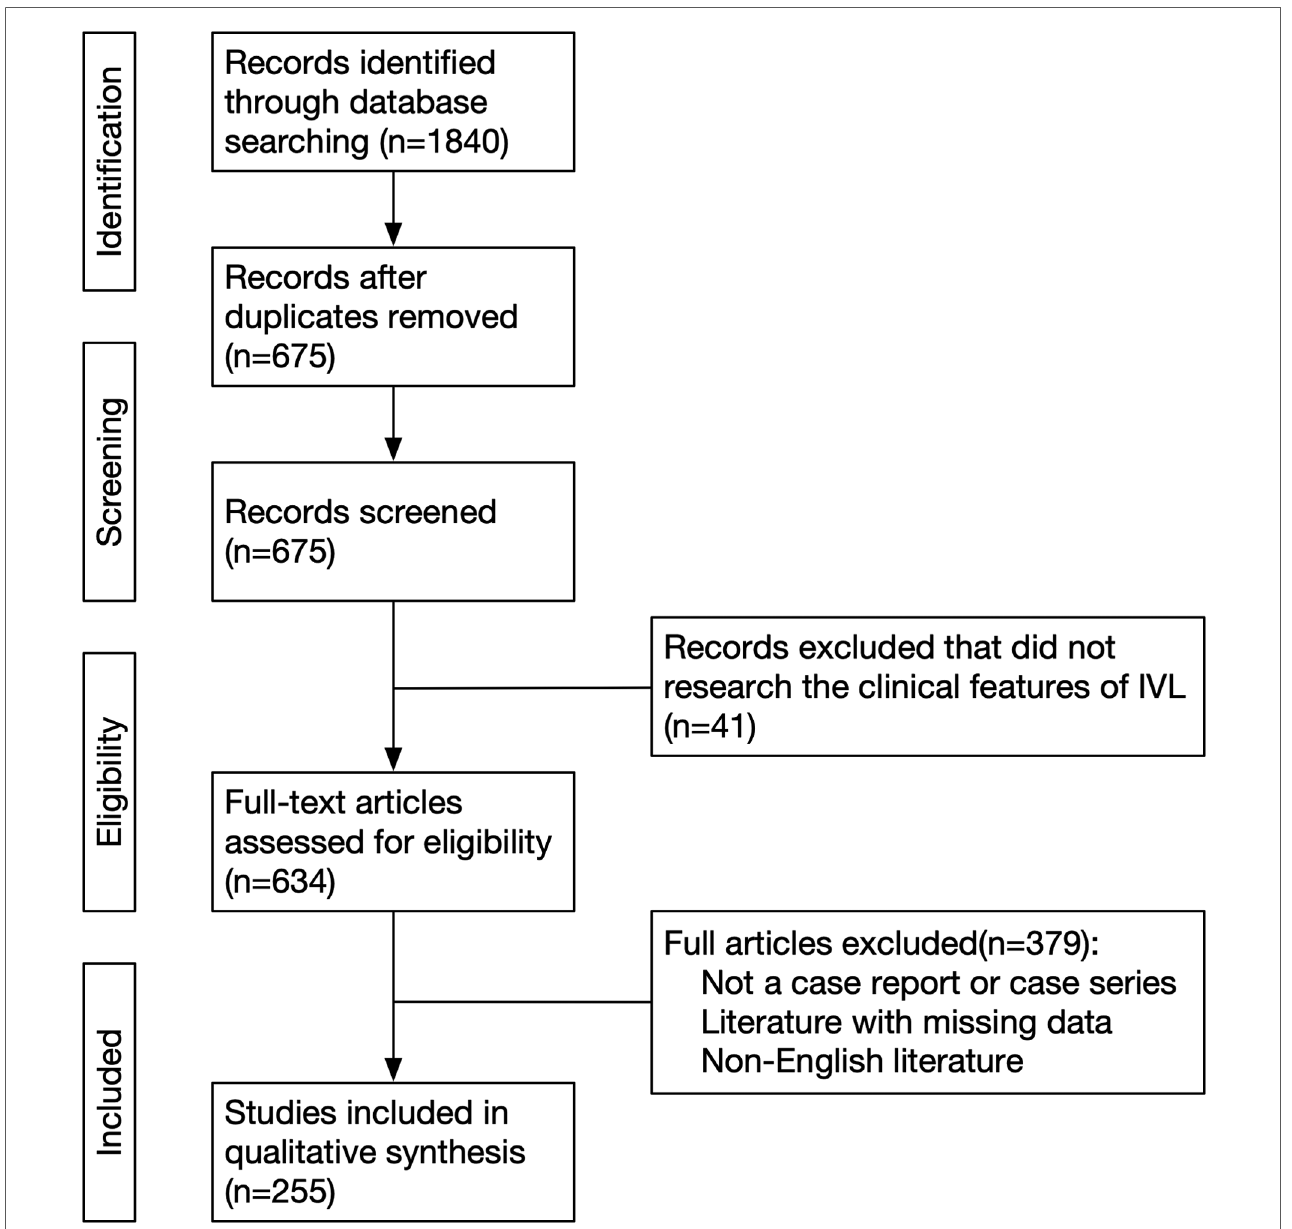
FIGURE 1 Flow diagram of literatures searching. IVL, intravenous